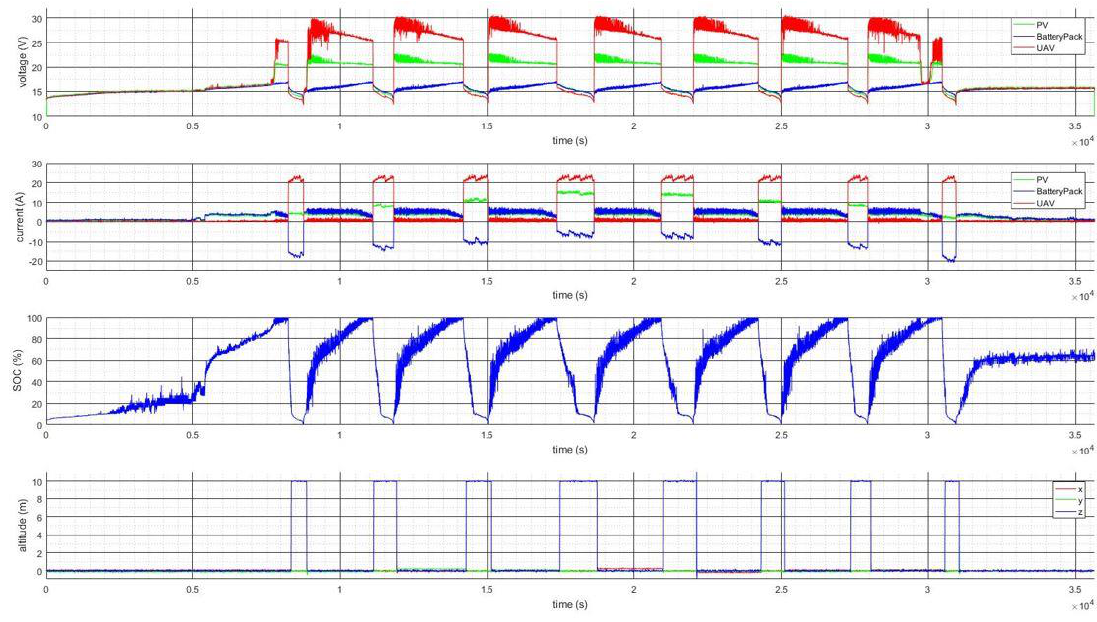
Figure 11. Indoor HIL test result.